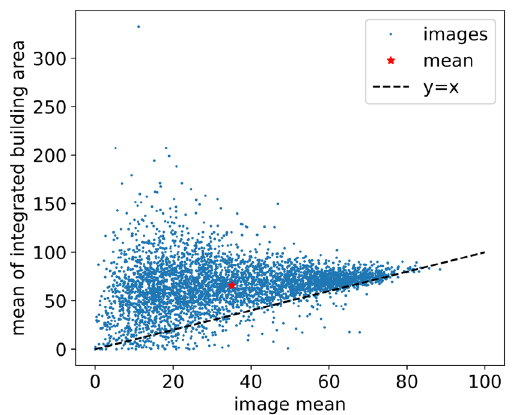
Figure 6. The mean of the symmetry density integrated within all building areas for each image containing buildings plotted against the mean of the symmetry density in the entire image shows that the area within buildings has a higher symmetry density than the average of the image for more than 93% of the